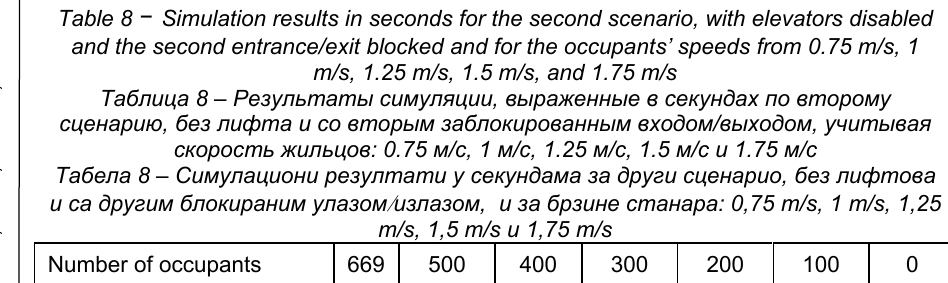
Table 8 – Simulation results in seconds for the second scenario, with elevators disabled and the second entrance/exit blocked and for the occupants’ speeds from 0.75 m/s, 1